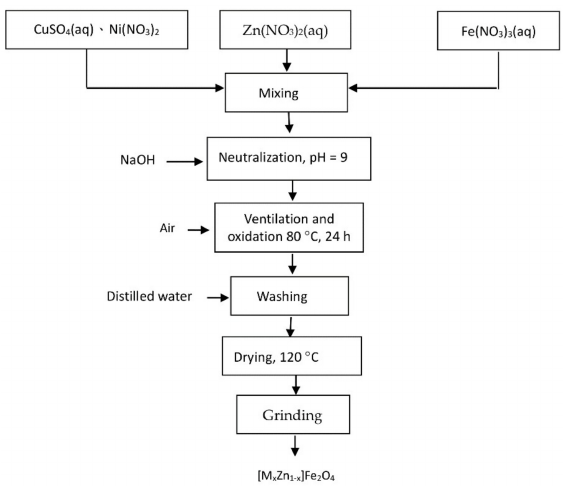
Figure 1. [M x Zn 1 − x ]Fe 2 O 4 ferrite